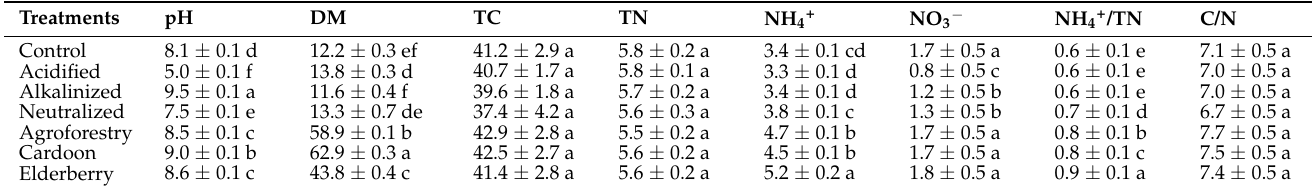
Table 2. Composition of the treatments at the beginning of the experiment (mean ± standard deviation) ( n =